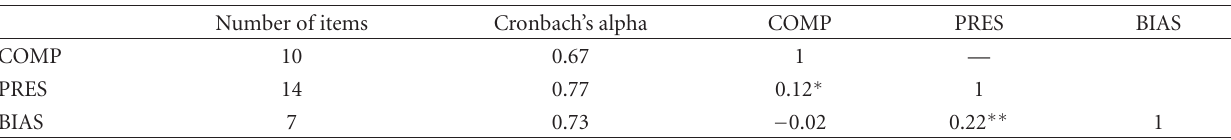
Table 5: Internal consistency reliability and correlations among the three-factor gender identity measure based on the Chinese sample ( N =